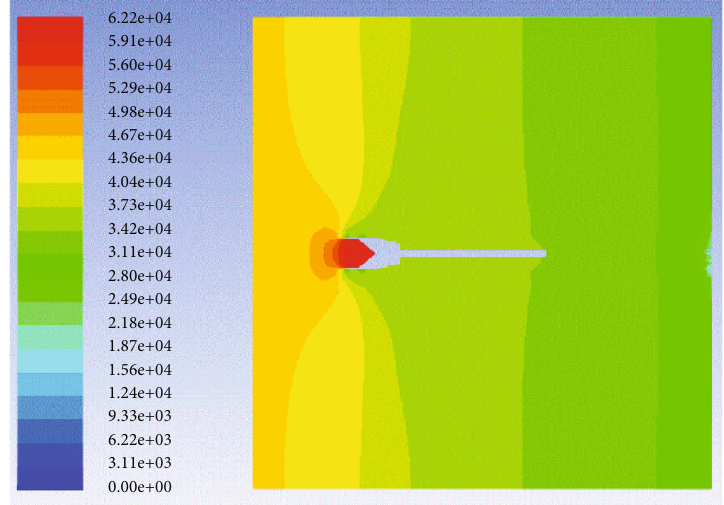
Figure 10: Pressure contour when v = 35 m / s , α = 0 ∘ .